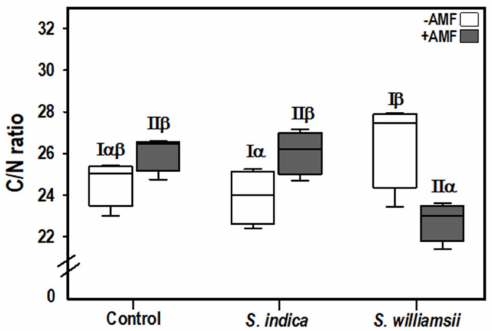
Figure 5. Carbon to nitrogen ratio (C / N) in the tomato shoots nine weeks after transplanting. (ANOVA, p < 0.05, n = 4). Greek letters were used to highlight significant interaction effects based on the simple effect analysis for − AMF(I) and +